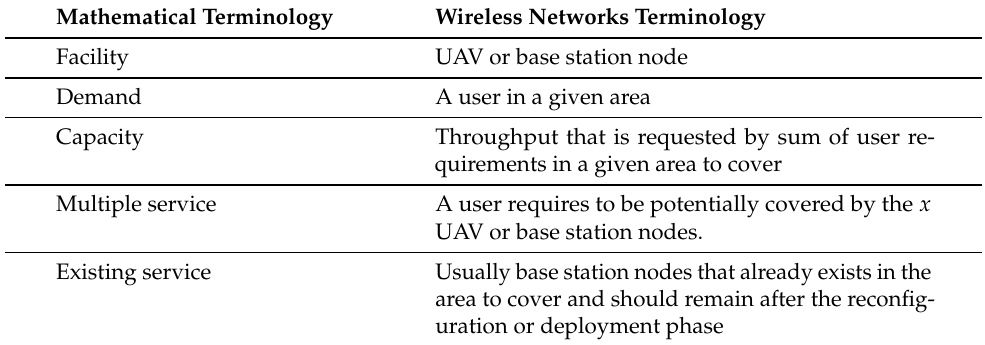
Table 2. Mapping mathematical terminology to communication networks